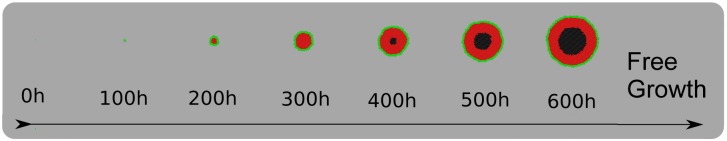
Image of the simulated tumor grown under free growth conditions, i.e., in the absence of any PMNs.This simulation corresponds to S1 Video.